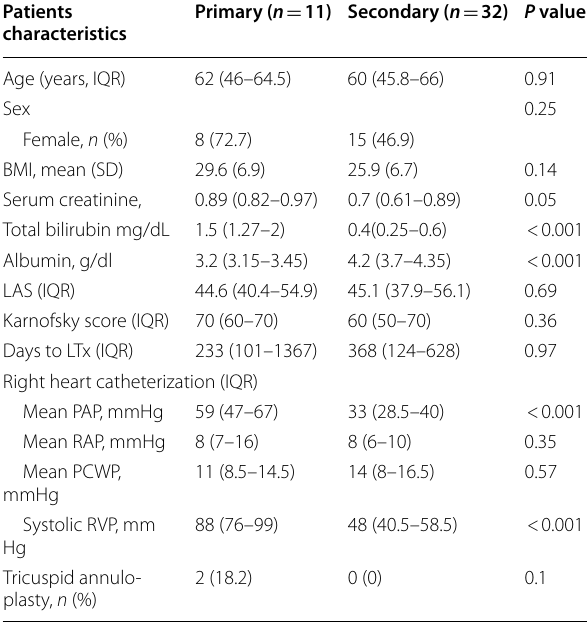
Table 3 Pulmonary artery hypertension primary vs secondary: baseline